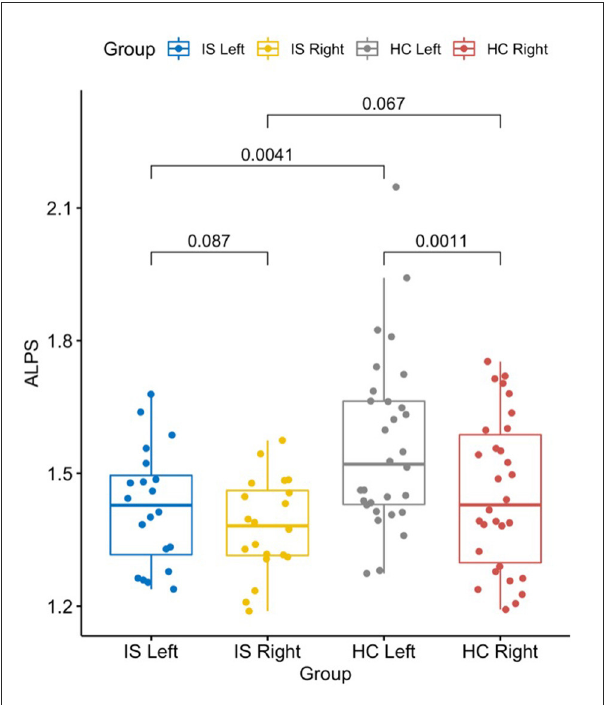
FIGURE4 The graph shows a significantly lower DTI-ALPS index in the left/stroke side of the brain in patients with IS than in HCs ( t = − 3.02, p = 0.004). The left side was also significantly higher than the right side in HCs ( t = 3.62, p = 0.001). Statistics shown in the graph